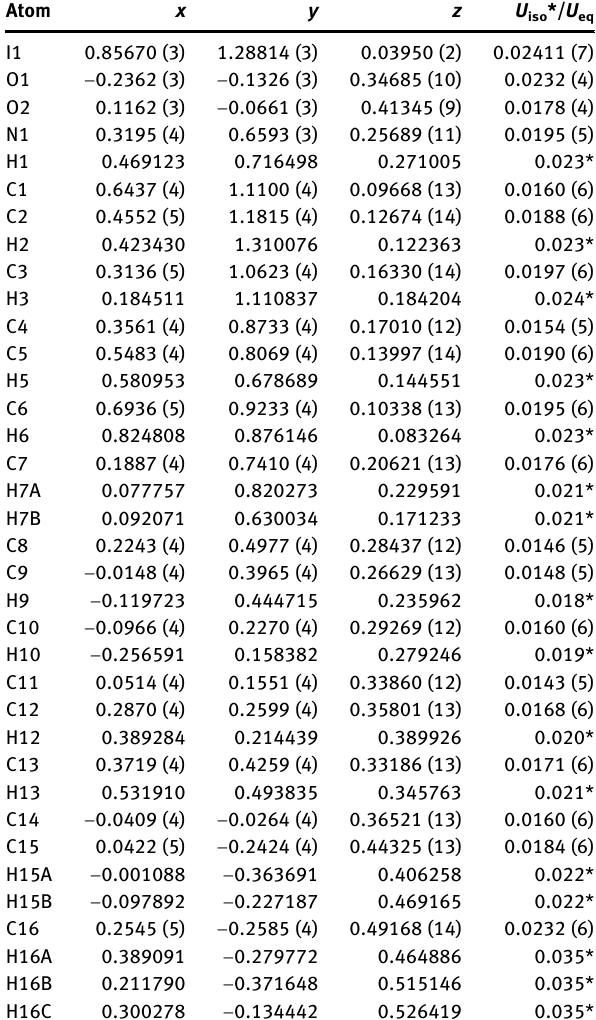
Table  : Fractional atomic coordinates and isotropic or equivalent isotropic displacement parameters (Å  ).